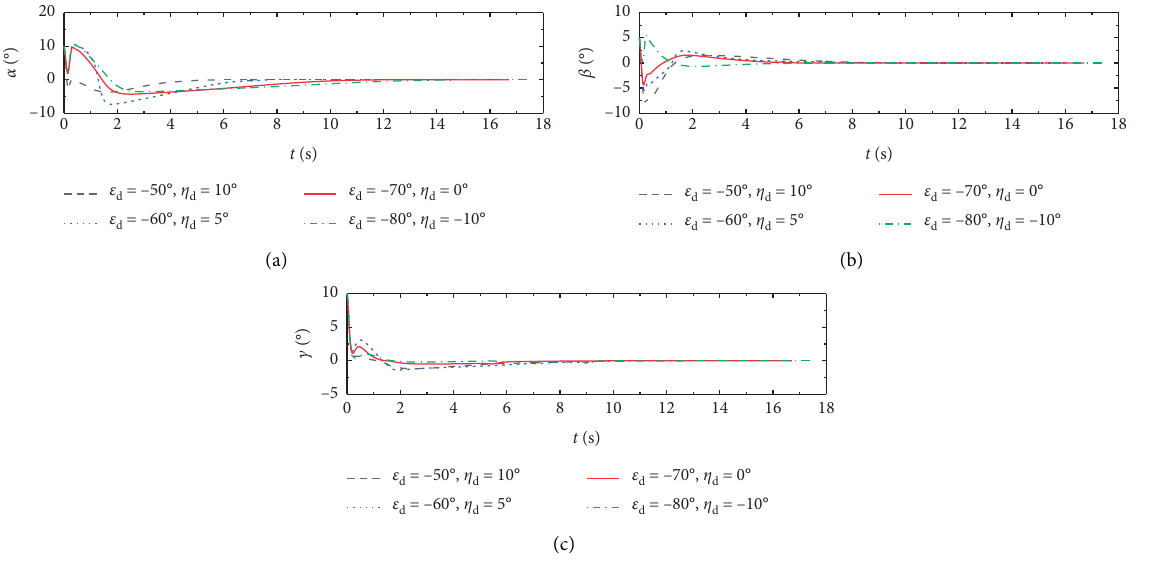
Figure 4: Curves representing attack, sideslip, and roll angles of Case 1.